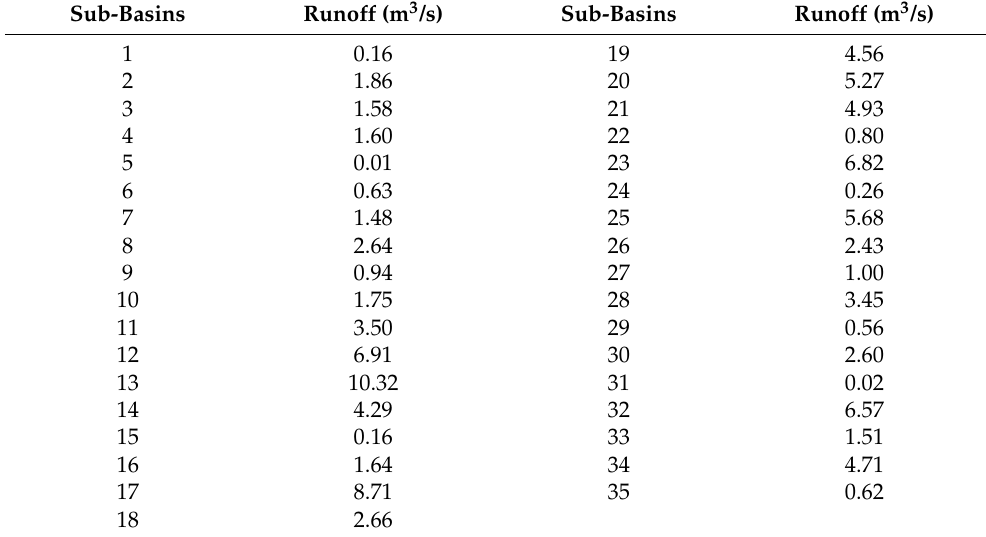
Table 6. Minimum flow of guaranteed water quality in